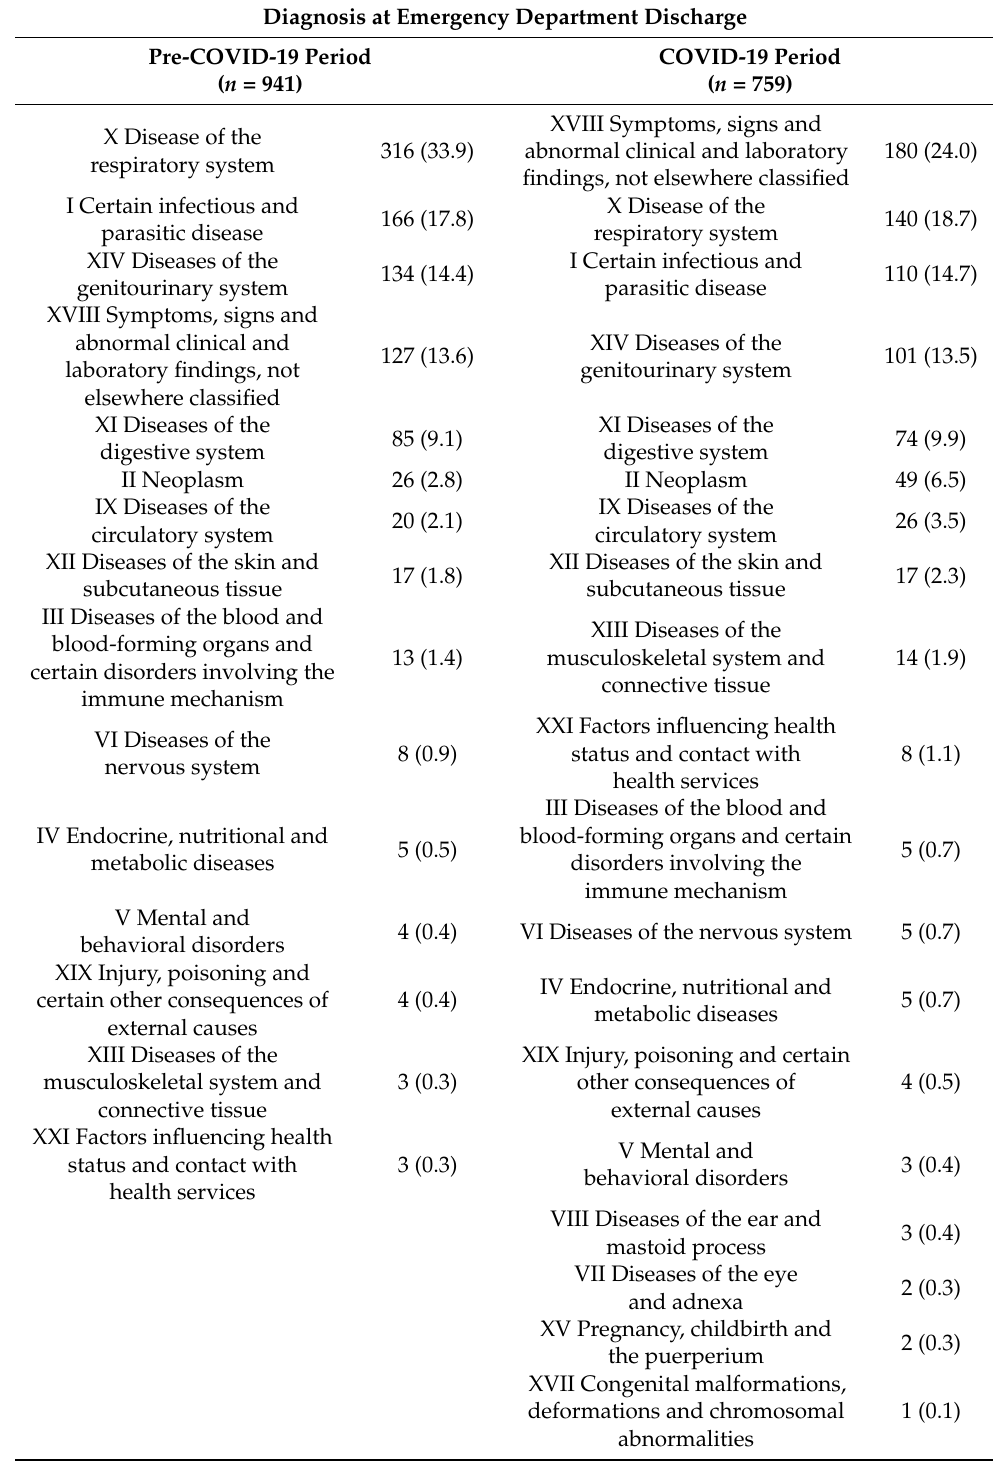
Table 2. The distribution of diagnosis according to the ICD-10 by the Pre- and COVID